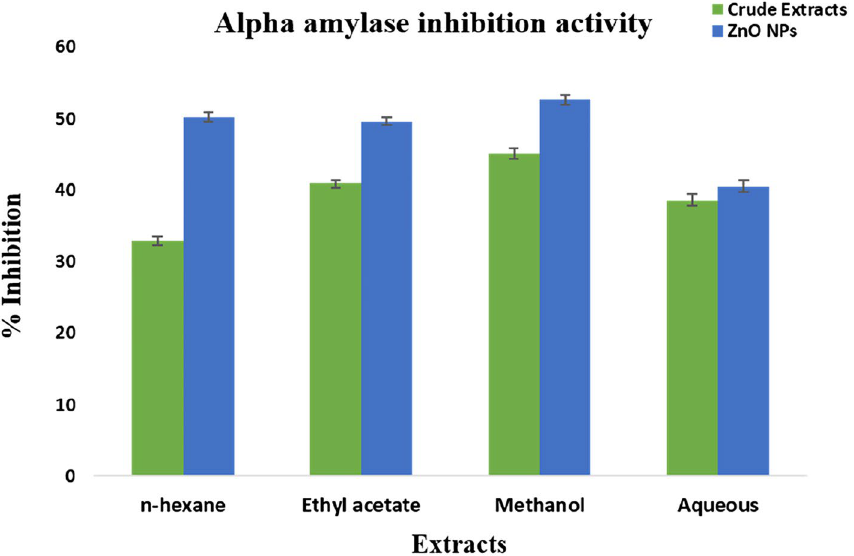
Figure 8. α-amylase inhibition potential of F. cretica crude extracts and its ZnO nanoparticles. Values given are expressed as the mean of triplicate ± standard